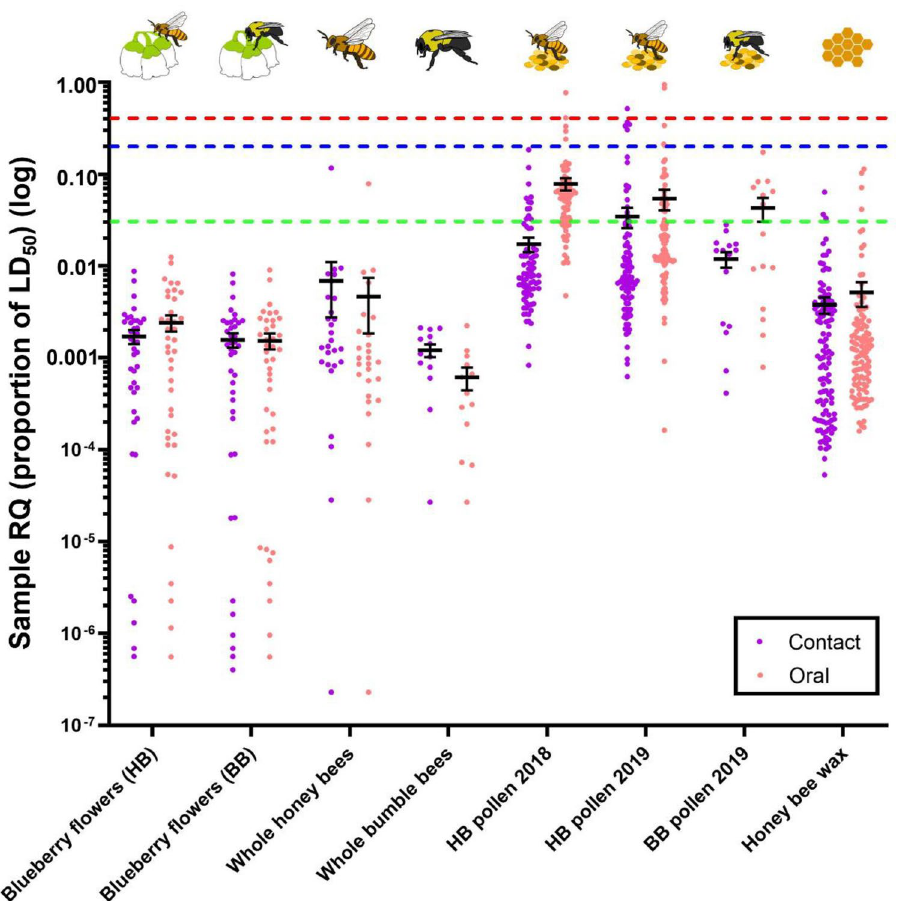
Figure 1. Average sample risk quotient by sample type. Risk quotient (RQ) was calculated with contact (purple) and oral (pink) LD 50 values. Toxicity data for Apis mellifera and Bombus terrestris were used depending on the sample type. Individual sample RQs are represented by the dots. Horizontal black lines are the mean, and the error bars represent standard error of the mean. RQ is displayed in relation to the EPA and EFSA levels of concern (proportion of the LD50). The green dashed line is the EFSA level of concern for chronic exposure (relevant for oral toxicity). The blue dashed line is the EFSA level of concern for acute exposure, and the red dashed line is the EPA level of concern for acute exposure. Graph created in GraphPad Prism 9 48